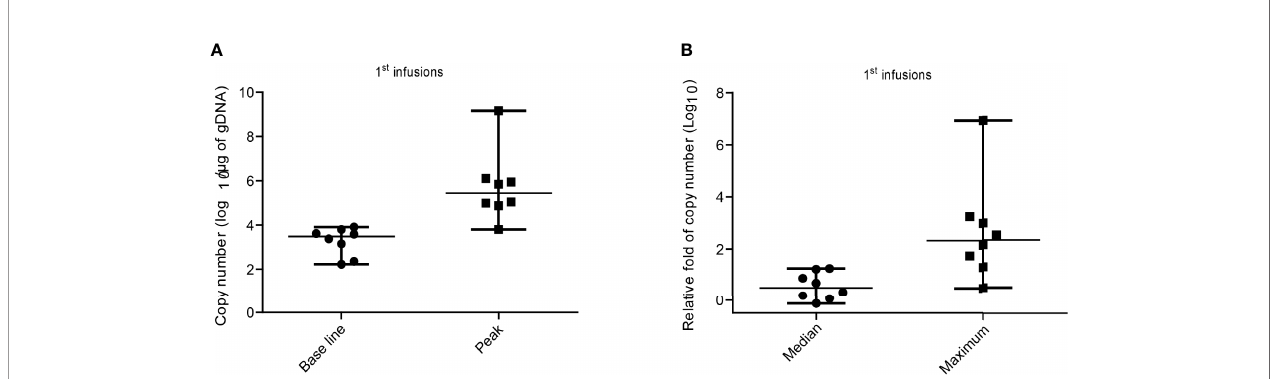
FIGURE 4 | CD19hs CAR-T expansion after the 1 st infusion in patients. (A) Expansion of CD19hs CAR gene copy numbers (n=8) after infusions. Base line was detected on the Day 0 before CD19hsCAR-T infusion; Peak means the Maximum CAR transgene copy number after infusions. (B) The relative fold change of CAR transgene copy numbers after infusions in patients (n = 8). Median means the relative fold medians in patients after 1 st infusions; Maximum means the peak values of relative fold in each objects. The data were presented as scatter dots with median and